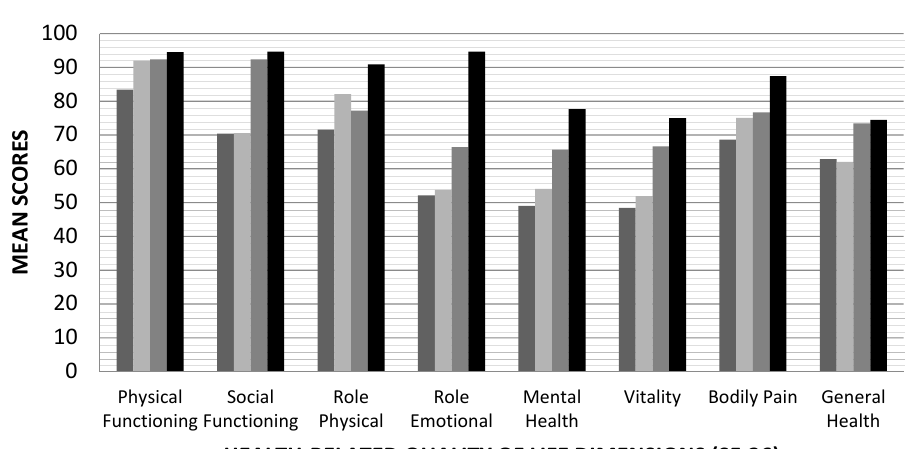
Figure 2. Mean scores in health-related quality of life dimensions (SF-36) according to the diagnosis and considering the presence of depressive symptomatology in dual depressed patients compared with the Spanish normative data in healthy individuals. SF-36: The Short Form Health Survey; SUD + MDD: Substance Use Disorder with comorbid Major Depression Disorder; SUD: Substance Use Disorder.